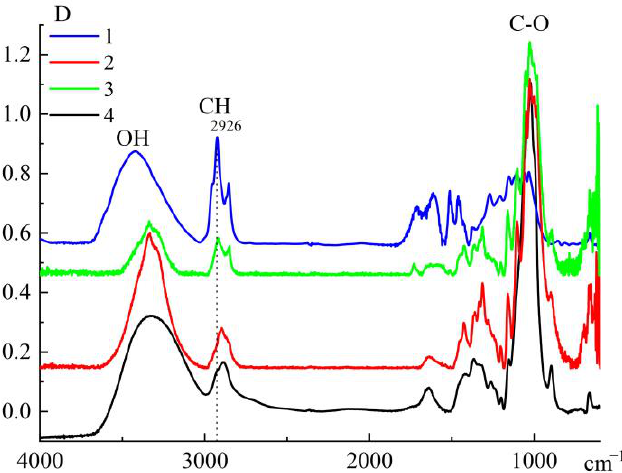
Figure 3. IR spectra of lignin (1), shives (2), noils (3) and Baikal wood cellulose (4). Attention is drawn to a significant change in the spectral pattern of the noils and shives samples in the region of 1450 – 1200 cm −1 in comparison with the spectrum of Baikal cellulose. In the spectrum of Baikal cellulose this region is poorly resolvable, however clear bands appear at 1426, 1365, 1333 and 1314 cm −1 which are the deformation vibrations of the -OH, -CH and -CH 2 groups in the shives and especially in the noils (Figure 4). Figure 4. Detailing the spectra of shives (2) and noils (3) with the spectra of lignin (1) and wood cellulose (4). The 2900 cm −1 (vCH), 1426 and 1370 cm −1 bands are used as internal standard bands to assess the degree of order in cellulose chains. The most sensitive to determining the degree of cellulose crystallinity is the relative intensity of the bands 1370 cm −1 /2900 cm −1 and 1426 cm −1 /900 cm −1 [49]. Our previous work [8] on the comparative evaluation of the crystallinity of long-fiber flax and wood pulp by the relative intensity of the 1430 cm −1 /900 cm −1 bands (O ’ Connor criterion) and by the relative intensity of the 1370 cm −1 /2900 cm −1 bands indicates that in flax cellulose, compared to wood pulp, both the intrachain and the interchain structural ordering are more highly expressed.